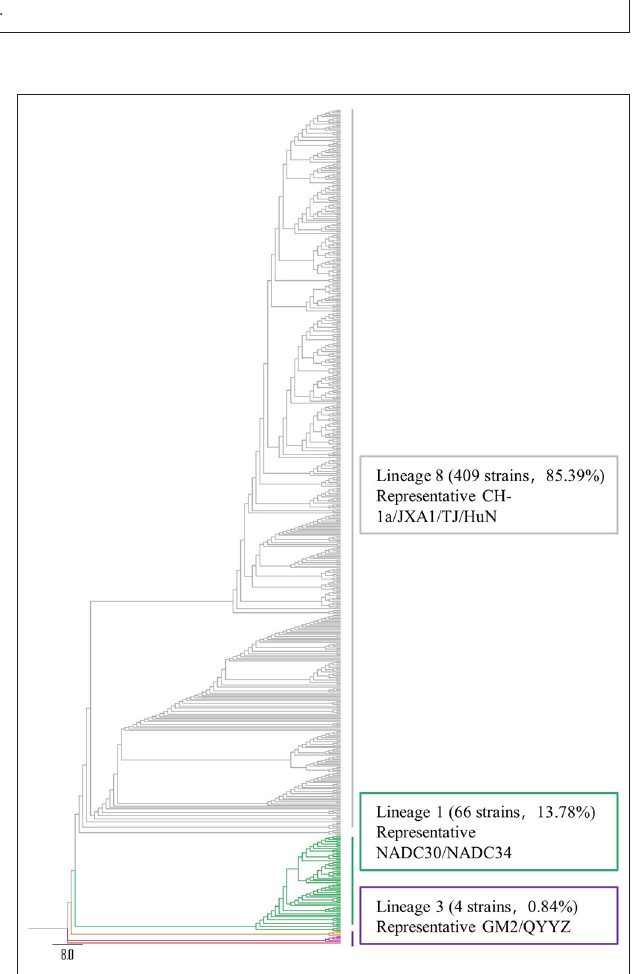
FIGURE 2 | Phylogenetic tree based on ORF5 sequence. Different phylogenetic cluster are shown in different colors. Sequences were aligned using the MegAlign program of DNASTAR, followed by phylogenetic analysis in MEGA 7 by using Neighbor-Joining method with bootstrap 100 times